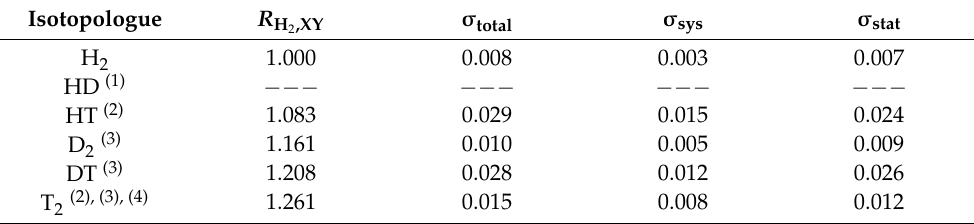
Table 5. C alibration factor ratios R H , obtained from the TRIHYDE H 2 -T 2 and D 2 -T 2 mixing 2 ,XY campaigns (II) and (III), respectively, with spectral sensitivity corrections applied; X, Y ∈ [H, D, T]. Isotopologue R H 2